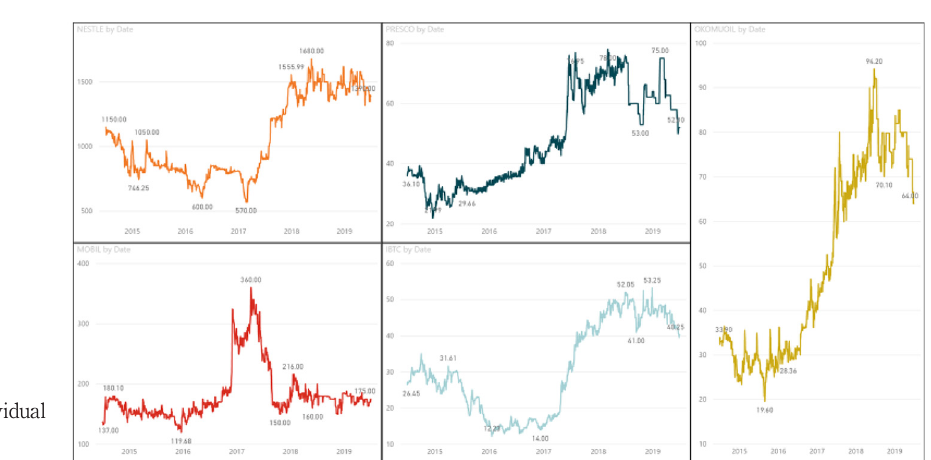
Figure A16. Portfolio B individual stocks